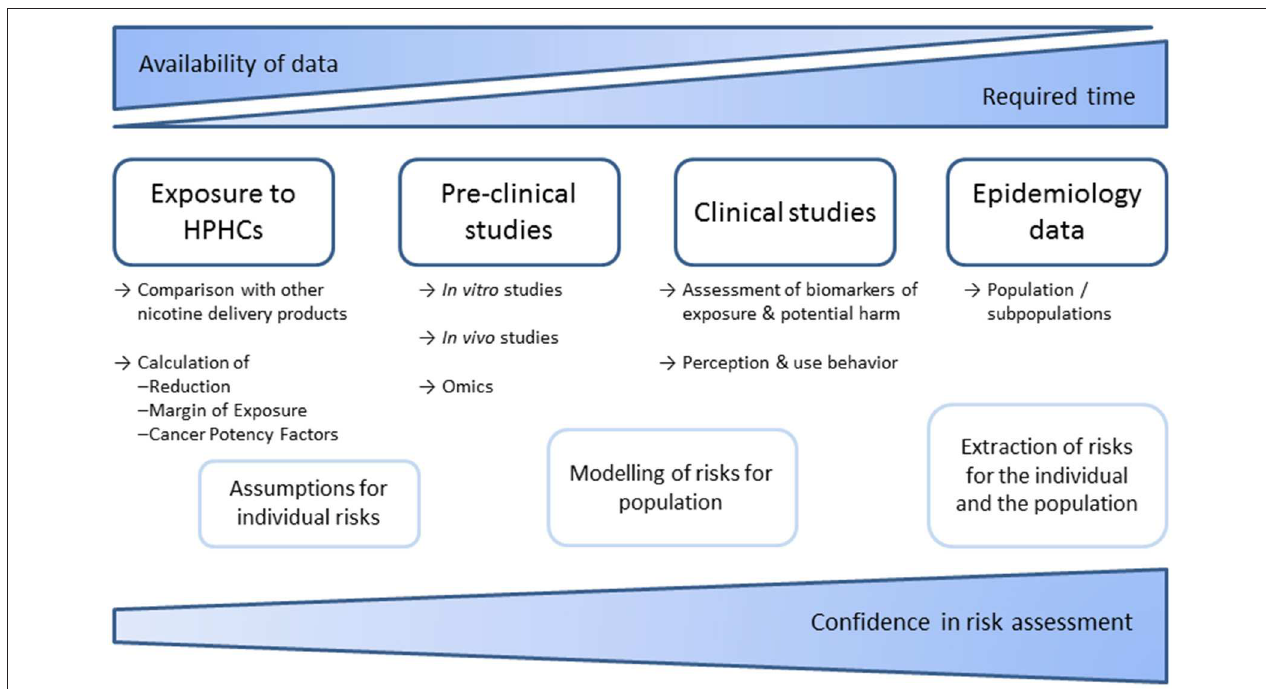
FIGURE 2 | Schematic overview of required data and studies to facilitate risk assessments of tobacco products. Epidemiological data are most conclusive but can usually only be used retrospectively. Therefore, risk assessments rely on models that consider emissions, pre-clinical and clinical studies. Meanwhile numerous studies on smoke chemistry and in vitro toxicology have been published by industry and independent researchers. In contrast, in vivo and clinical studies are far more complex. No sufficient independent data are